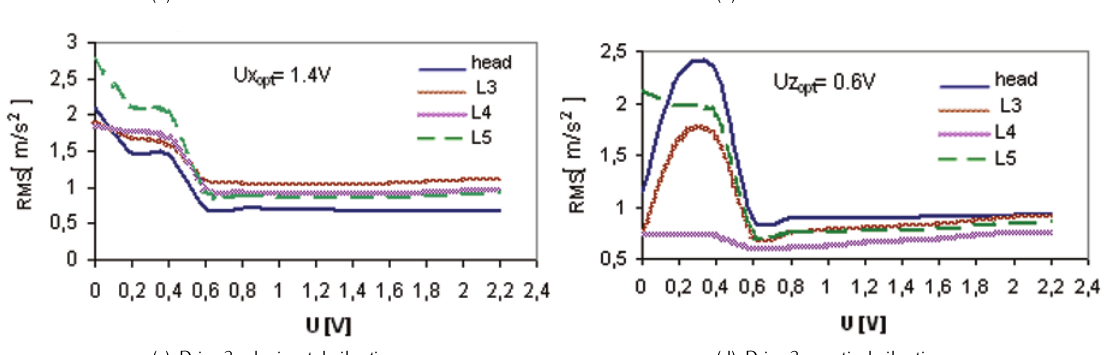
Fig 7. RMS accelerations of body structures of human model as a function of MR control voltage: (a) horizontal vibration (driver 1), (b) vertical vibration (driver 1), (c) horizontal vibration (driver 2), (d) vertical vibration (driver 2).